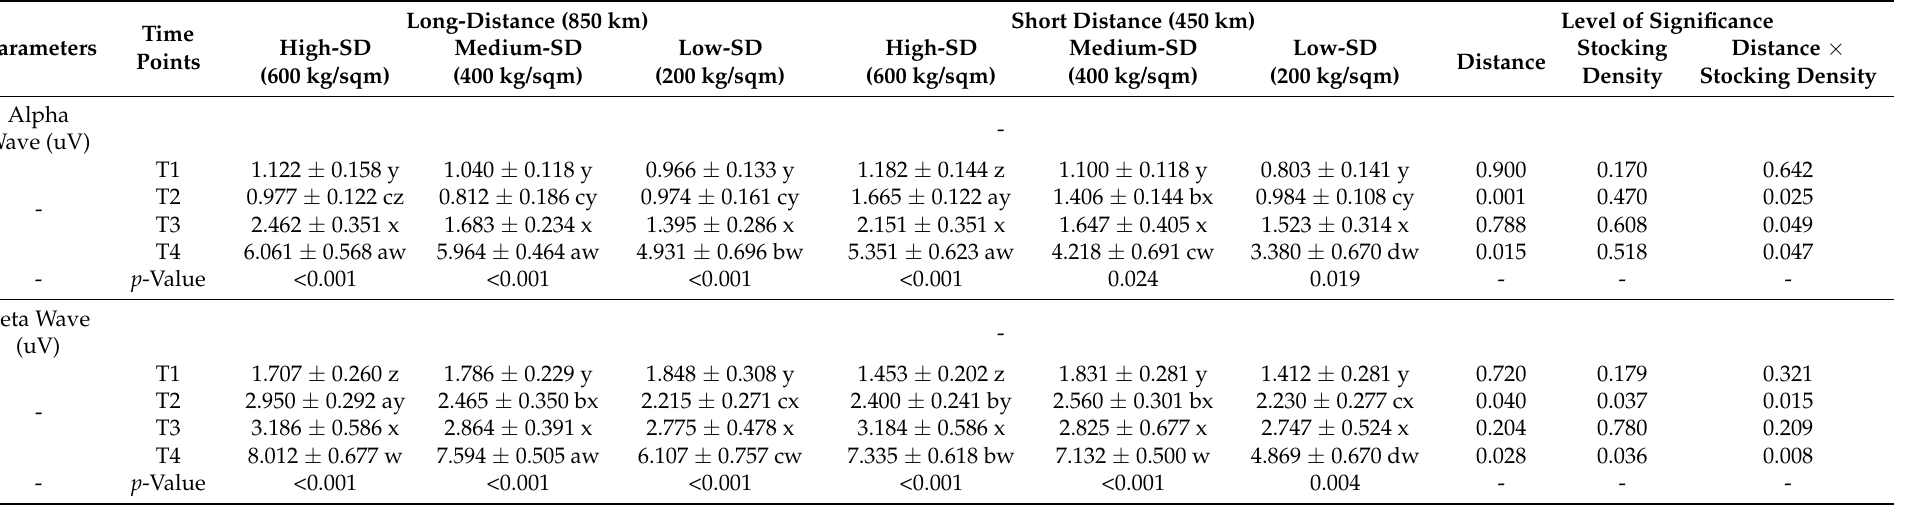
Table 1. Influence of distances and stocking density on the encephalogram of Brahman crossbred cattle (alpha and beta waves) (Mean ± SE).